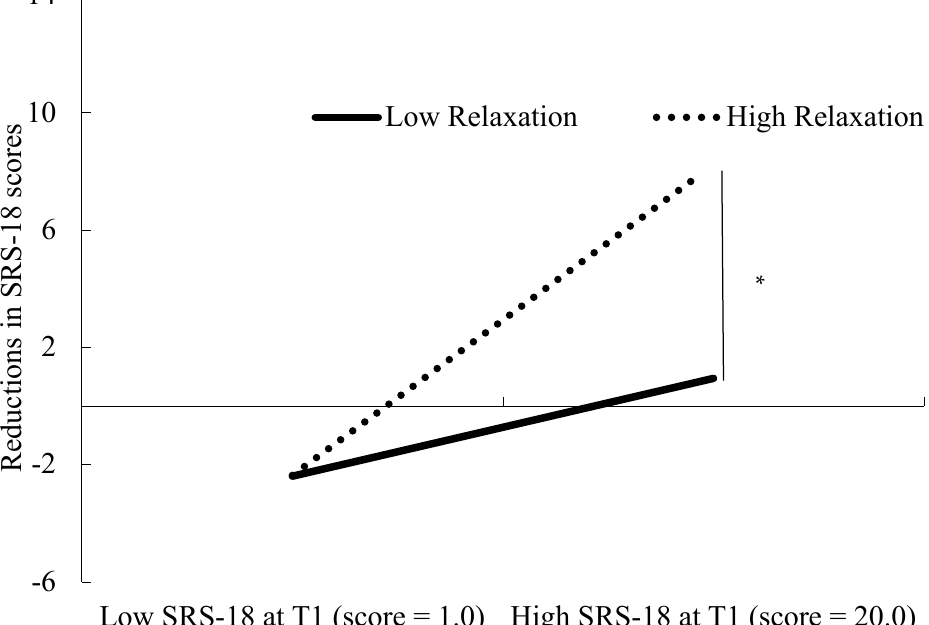
Figure 1. Effect of the significant interaction between the psychological stress response at T1 and relaxation on the reduction of the psychological stress response. T1: Time 1; SRS-18: Stress Response Scale-18. * p < 0.01